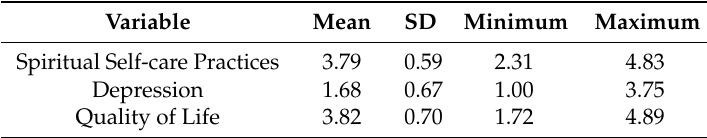
Table 3. Descriptive statistics of the study variables ( N = 142).